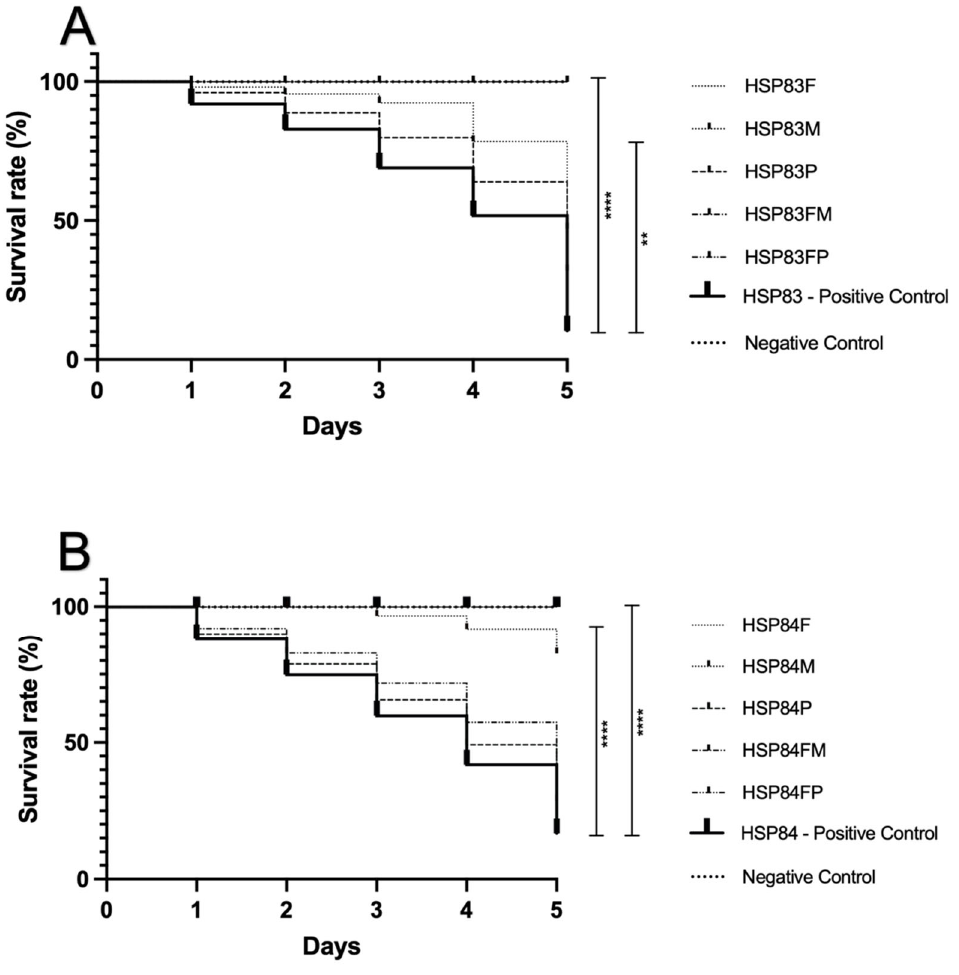
Figure 2. Galleria mellonella infection model. ( A ) Kaplan–Meier plots for larvae inoculated with HSP83 isolate. The curves obtained indicate that fosfomycin and meropenem alone, as well as fosfomycin + meropenem combination, presented a significative higher survival rate compared to a positive control (bacteria inoculated and not treated). Polymyxin B in monotherapy and fosfomycin + polymyxin B combination did not achieve a significant difference. ( B ) Kaplan–Meier plots for lar ‐ vae inoculated with HSP84 isolate. The curves obtained indicate that fosfomycin and meropenem alone, as well as fosfomycin in combination with meropenem or polymyxin B, presented a signifi ‐ cative higher survival rate compared to a positive control (bacteria inoculated and not treated). Pol ‐ ymyxin B in monotherapy did not achieve a significant difference. F, fosfomycin alone; M, mero ‐ penem alone; P, polymyxin B alone; FM, fosfomycin + meropenem combination; FP, fosfomycin + polymyxin B combination; HSP83 ‐ or HSP84 ‐ positive control, larvae not treated; negative control, larvae inoculated with saline. ( p ‐ value: ** < 0.005; **** < 0.0001). The assay was performed with ten larvae per group and in duplicate.